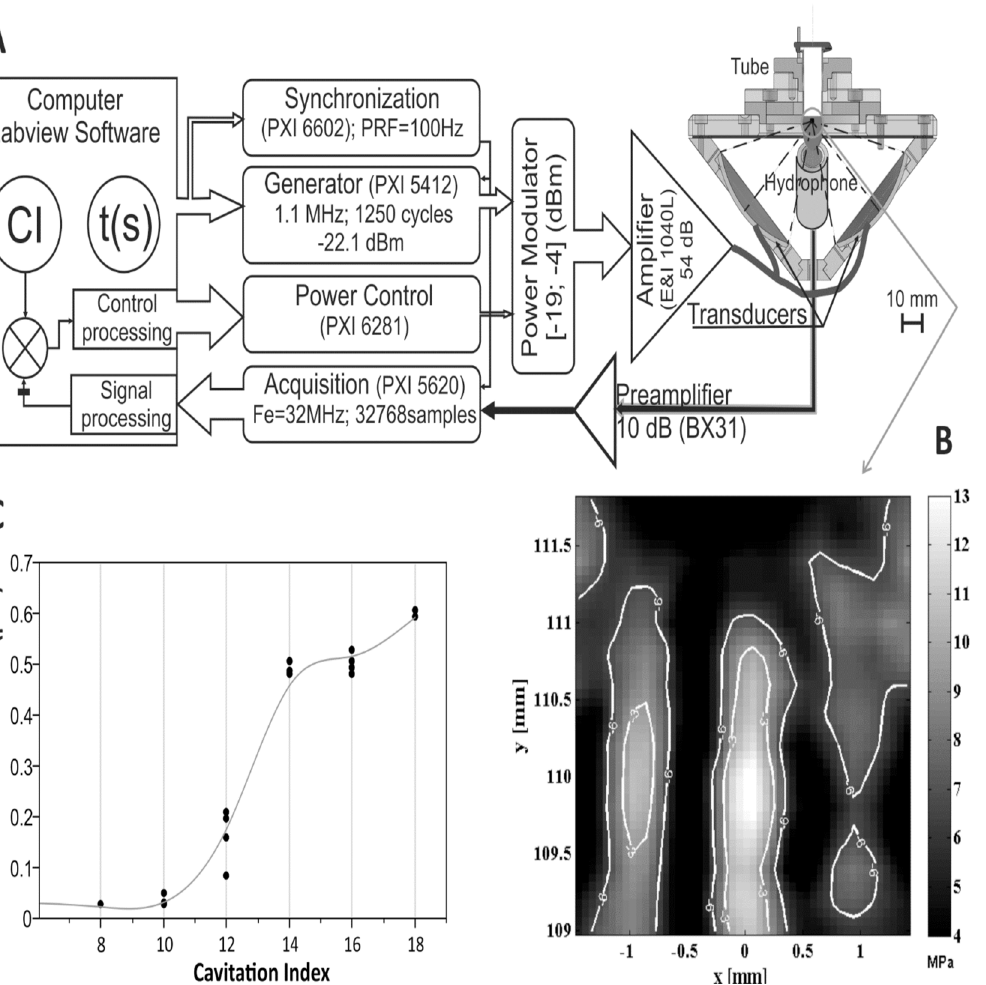
Fig 1. Experimental setup, cavitation control and pressure application. (A) Experimental setup. (B) Pressure field (dB) at the focal point (C) Relationship between the measured fluorescence levels in 550 μ L of terephthalic acid medium (20 mM) and the cavitation index (sonication time: 60 seconds).